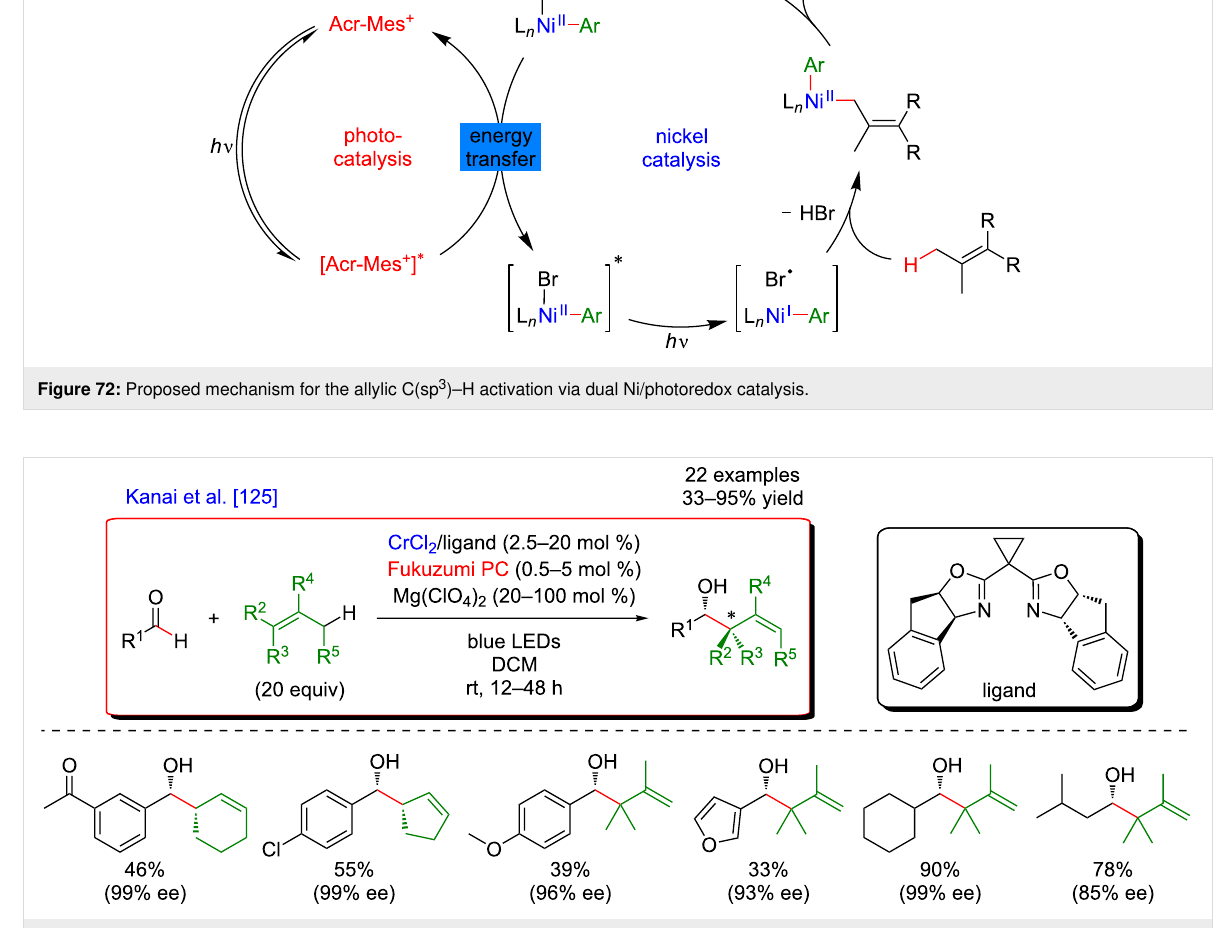
Figure 73: Asymmetric allylation of aldehydes via dual Cr/photoredox